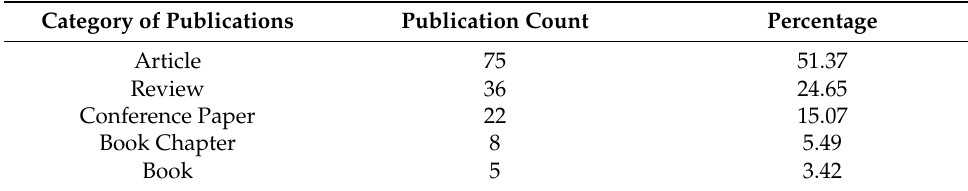
Table 2. Classification of Publications for IOT in agriculture.